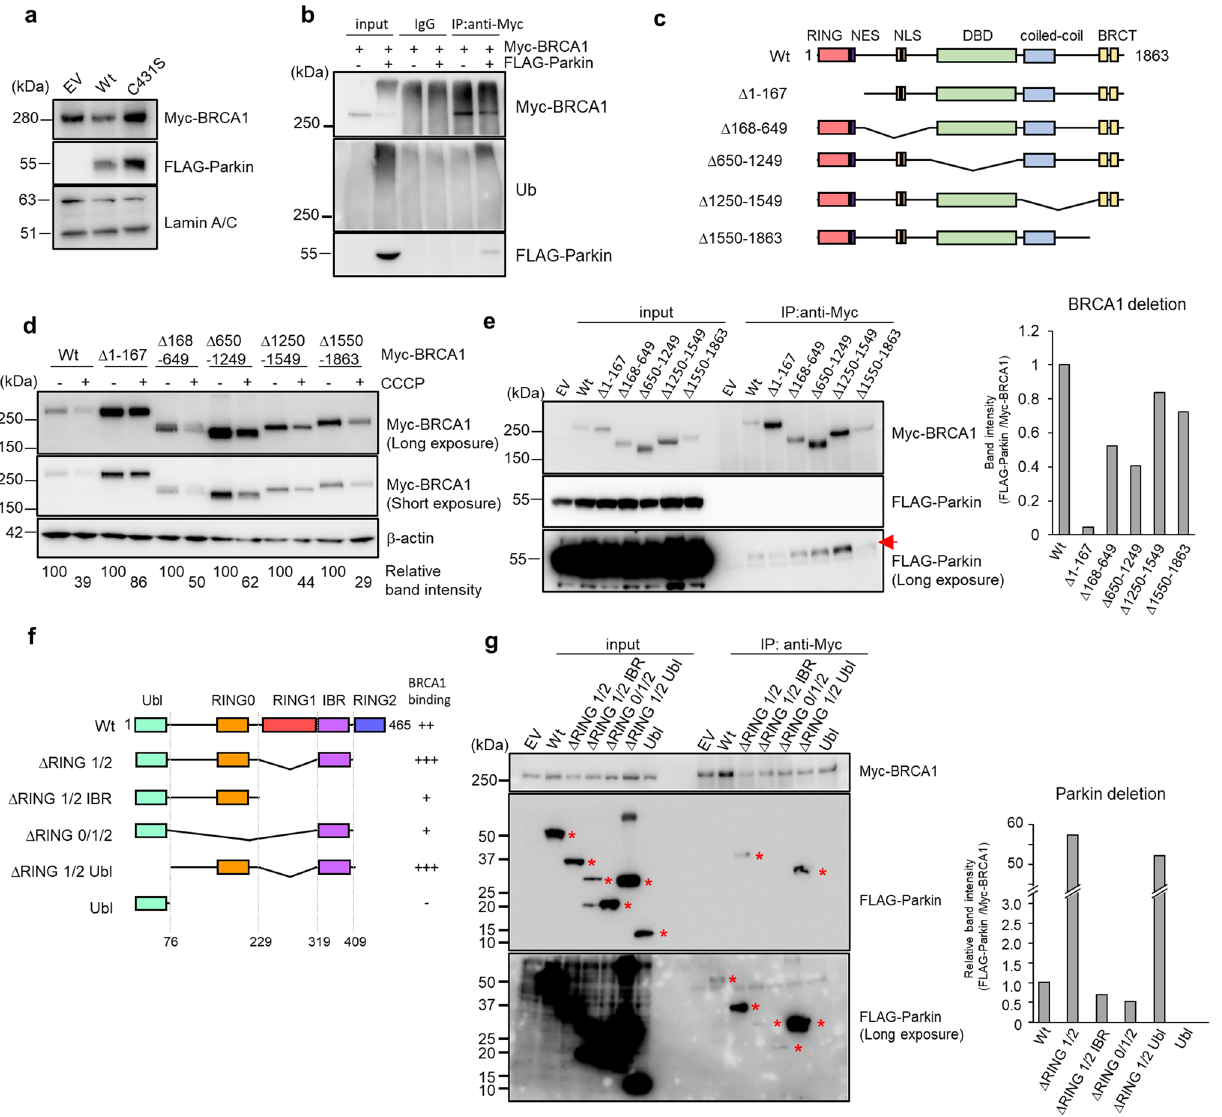
Figure 3. Parkin directly interacts with BRCA1. ( a ) Western blotting analysis for Myc-BRCA1 with the nuclear extract from HEK293T cells transfected with Myc-BRCA1 and empty vector (EV), wild type FLAG-Parkin (Wt), or C431S mutant FLAG-Parkin (C431S). Lamin A/C was used as a loading control. ( b ) Nuclear extracts of HEK293T cells transduced with Myc-BRCA1 and FLAG-Parkin expression vectors or an empty vector, and then treated with MG132, were subjected to Co-IP assays. Immunoprecipitates were subjected to Western blotting for Myc-BRCA1, Ub, and FLAG-Parkin. ( c ) Schematic diagram of BRCA1 expression-constructs. The degron domain is located at a.a. 1–167. The RING domain, DBD (DNA binding domain), coiled-coil domain, BRCT (BRCA1 C-terminal) domain, NES (nuclear export sequence), and NLS (nuclear localization sequence) are boxed and labeled at the top. ( d ) The expression vector for the Myc-tagged full length or deletion mutant of BRCA1 shown in (C) was transfected into HEK293T cells, which were subsequently treated with or without 10 μM CCCP for 24 h. Next, protein levels were assessed by Western blotting. Relative Myc-BRCA1 band intensity is indicated at the bottom of the figure. ( e ) Coimmunoprecipitation of FLAG-Parkin with Myc- BRCA1 deletion mutants. The arrow shows the signal of FLAG-Parkin. The band intensities of FLAG-Parkin standardized by Myc-BRCA1 in the IP samples are summarized on the right side. ( f ) Schematic diagrams of Parkin expression constructs. The binding capacity of each construct for Myc-BRCA1 is summarized on the right side. The Ubl (ubiquitin-like) domain, RING0/1/2 domains, and IBR (in-between-RING) domains are boxed and labeled at the top. ( g ) Coimmunoprecipitation of FLAG-Parkin deletion mutants with Myc-BRCA1 was analyzed by Western blotting. Asterisks indicate FLAG-Parkin. The band intensities of FLAG-Parkin standardized against Myc-BRCA1 in the IP samples are summarized on the right